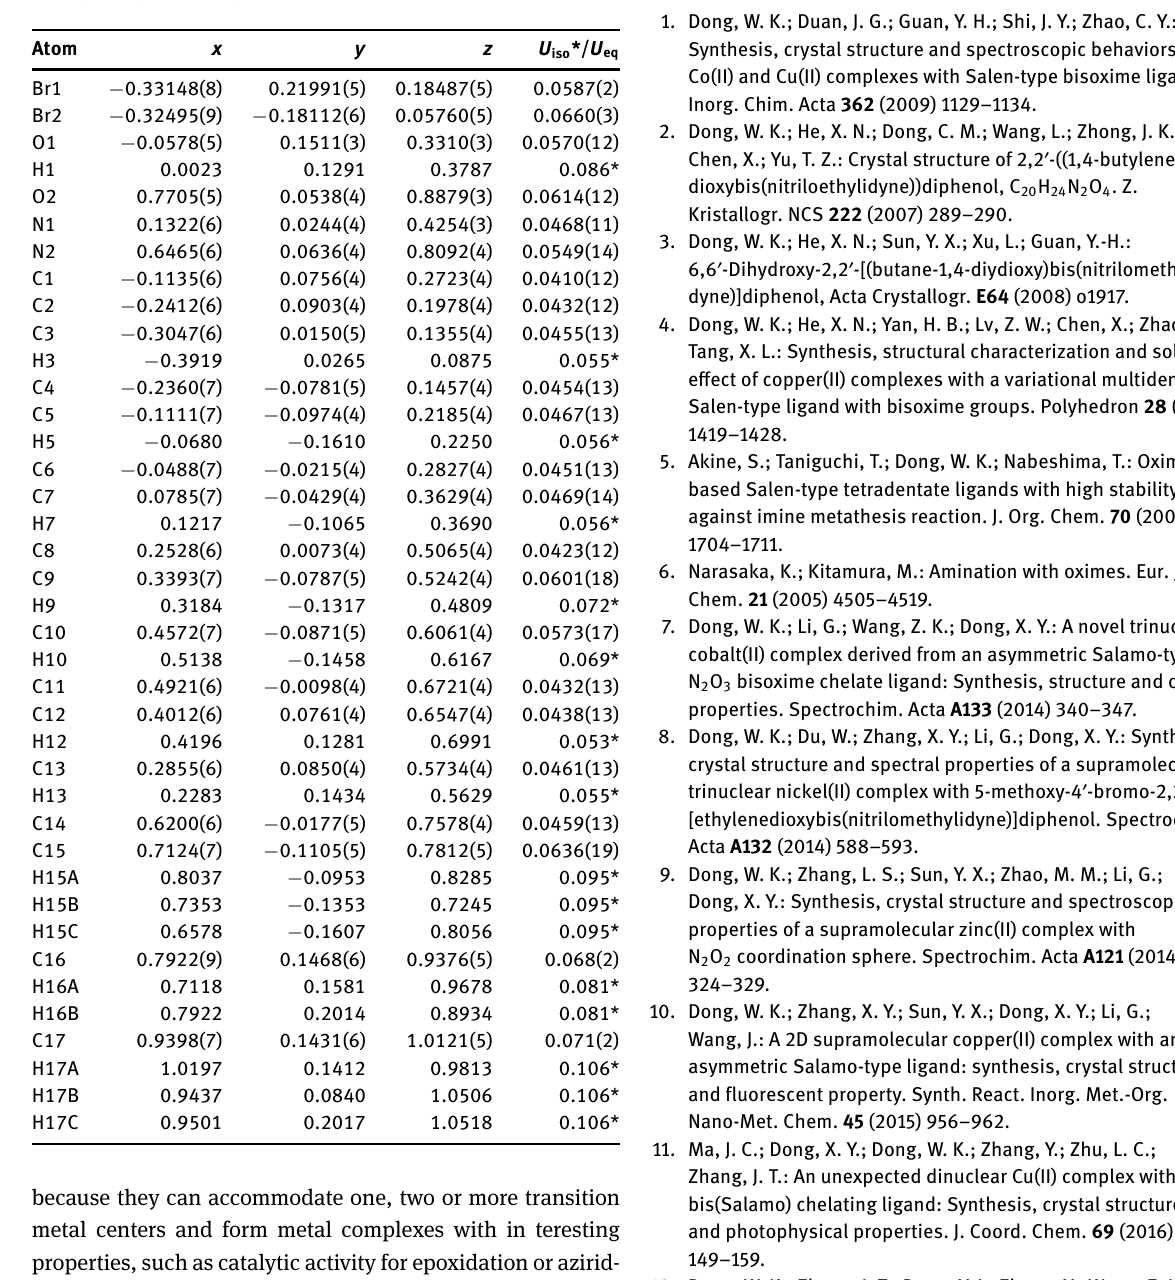
Table 2: Fractional atomic coordinates and isotropic or equivalent isotropic displacement parameters (Å 2